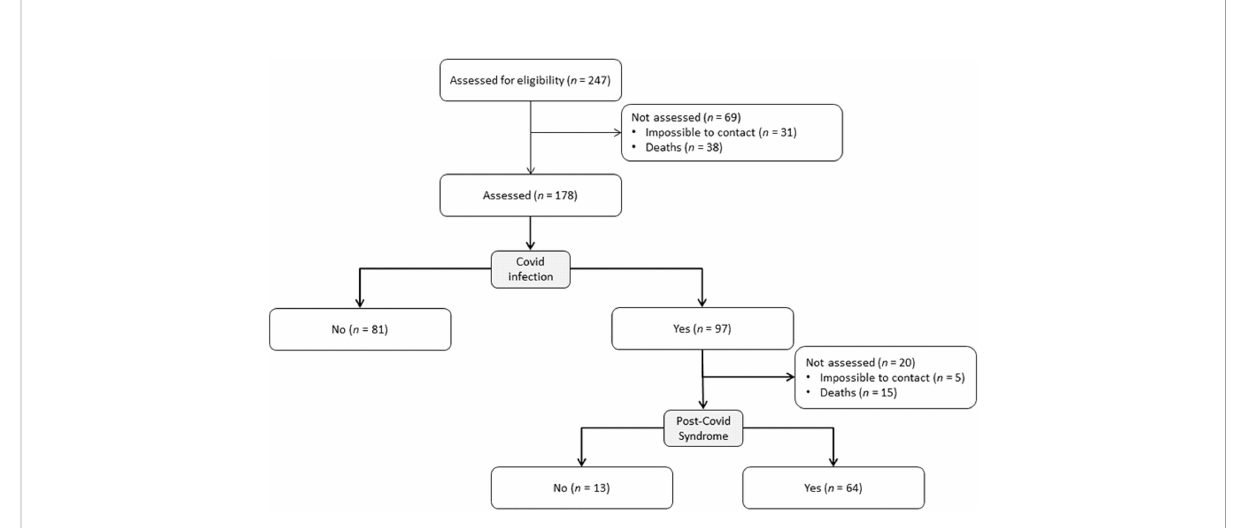
FIGURE 1 Participant ’ s fl